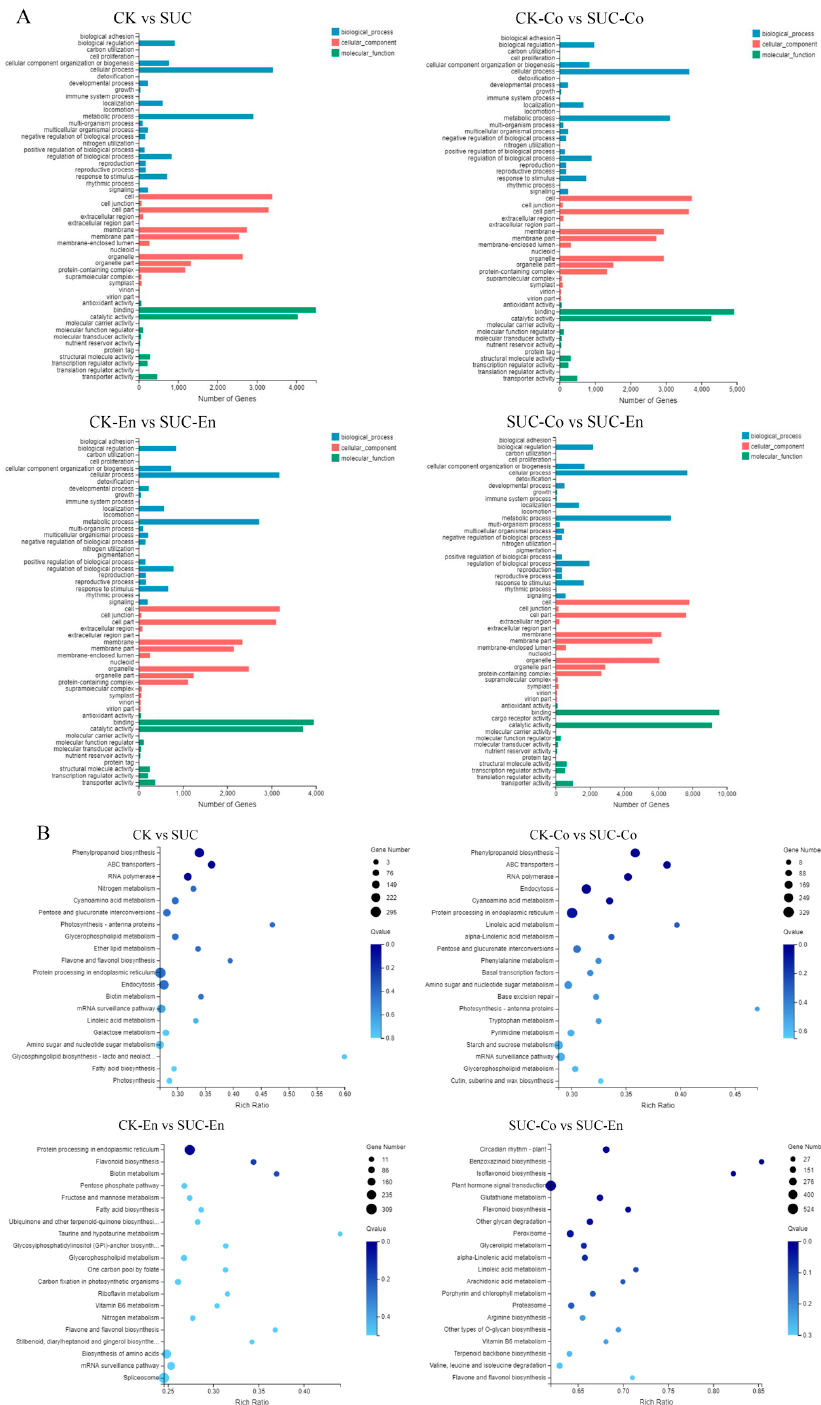
Figure 4. GO and KEGG Pathway analysis of DEGs. ( A ) Functional distribution of DEGs annotated GO. The x -axis represents the number of genes annotated GO, and the y -axis stands for the functional distribution of GO. ( B ) Bubble Diagram of enrichment of DEGs KEGG pathway. The x -axis is enrichment ratio, the y -axis is KEGG Pathway, the bubble size indicates the number of genes annotated on one KEGG pathway, the color represents enrichment Q-value, and darker color represents smaller Q-value. CK, seed as the control; SUC, seed with sucrose treatment; CK-Co, seed coat as the control; SUC-Co, seed coat with sucrose treatment; CK-En, endosperm as the control; SUC-En, endosperm with sucrose treatment.